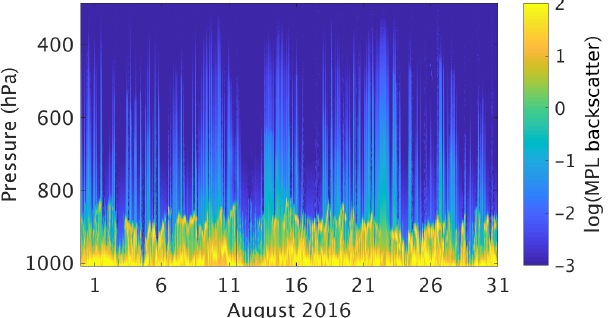
Figure 3. The log of the micropulse lidar (MPL) backscatter over Ascension Island during August 2016.